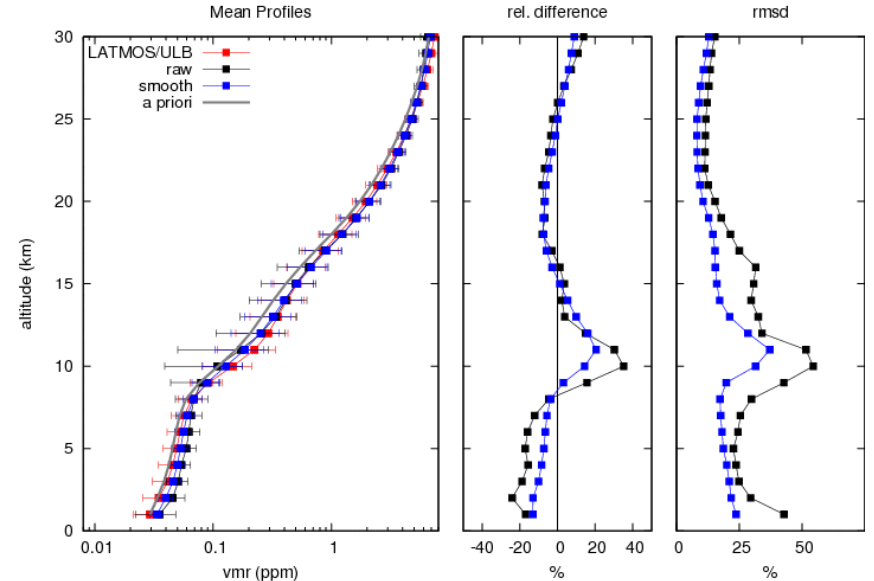
39Figure 4. same as Fig. 3 for the LATMOS/ULB product Fig. 4. Same as Fig. 3 for the LATMOS/ULB product.